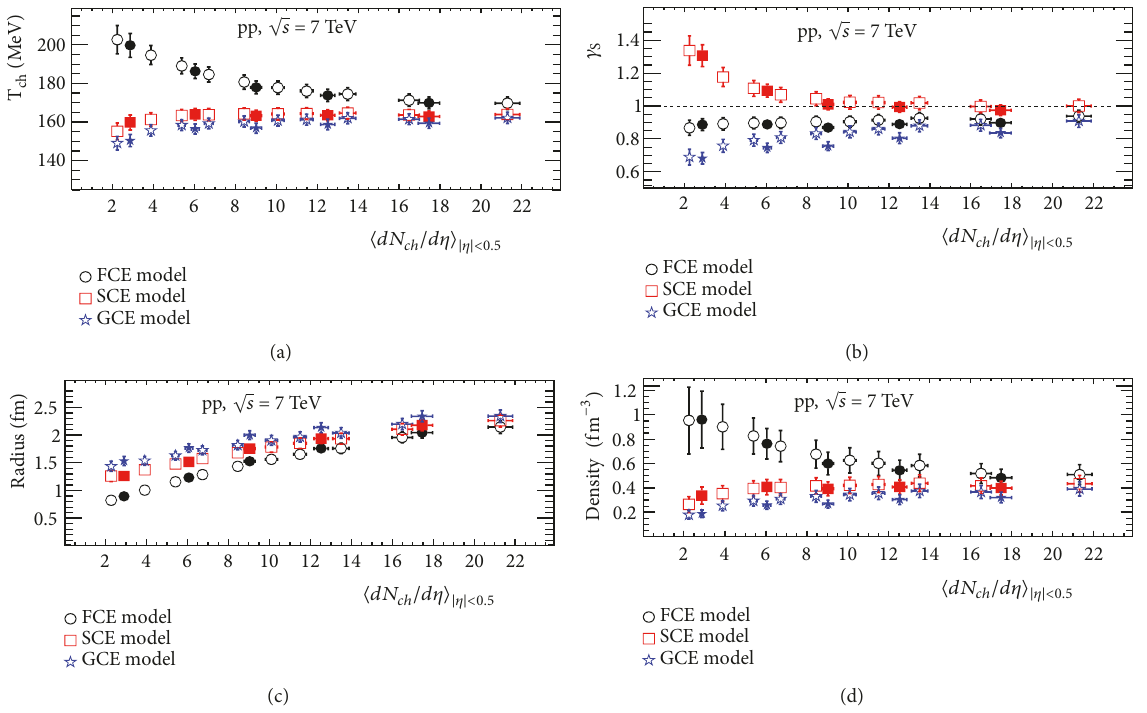
Figure 1: The chemical freeze-out temperature 𝑇 ch obtained for three different ensembles in panel (a). The strangeness suppression factor, 𝛾 𝑠 is shown in panel (b). The radius of the system at chemical freeze-out is shown in panel (c). The density is shown in panel (d). The open symbols show results of fitting hadrons yields without Ω whereas solid symbols show fit results including Ω yields.